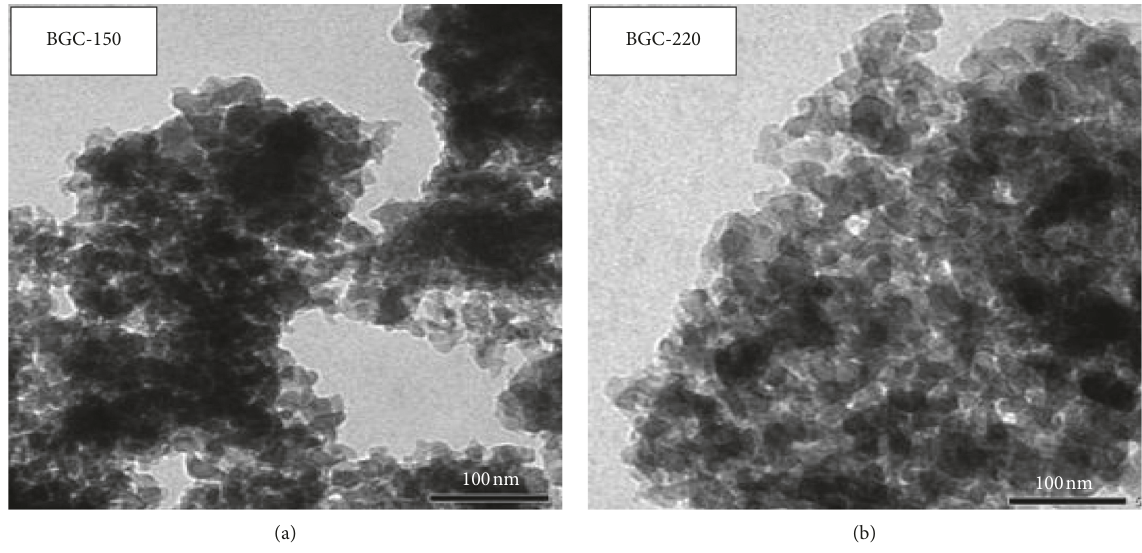
Figure 4: TEM images of BGC-150 and BGC-220 samples.